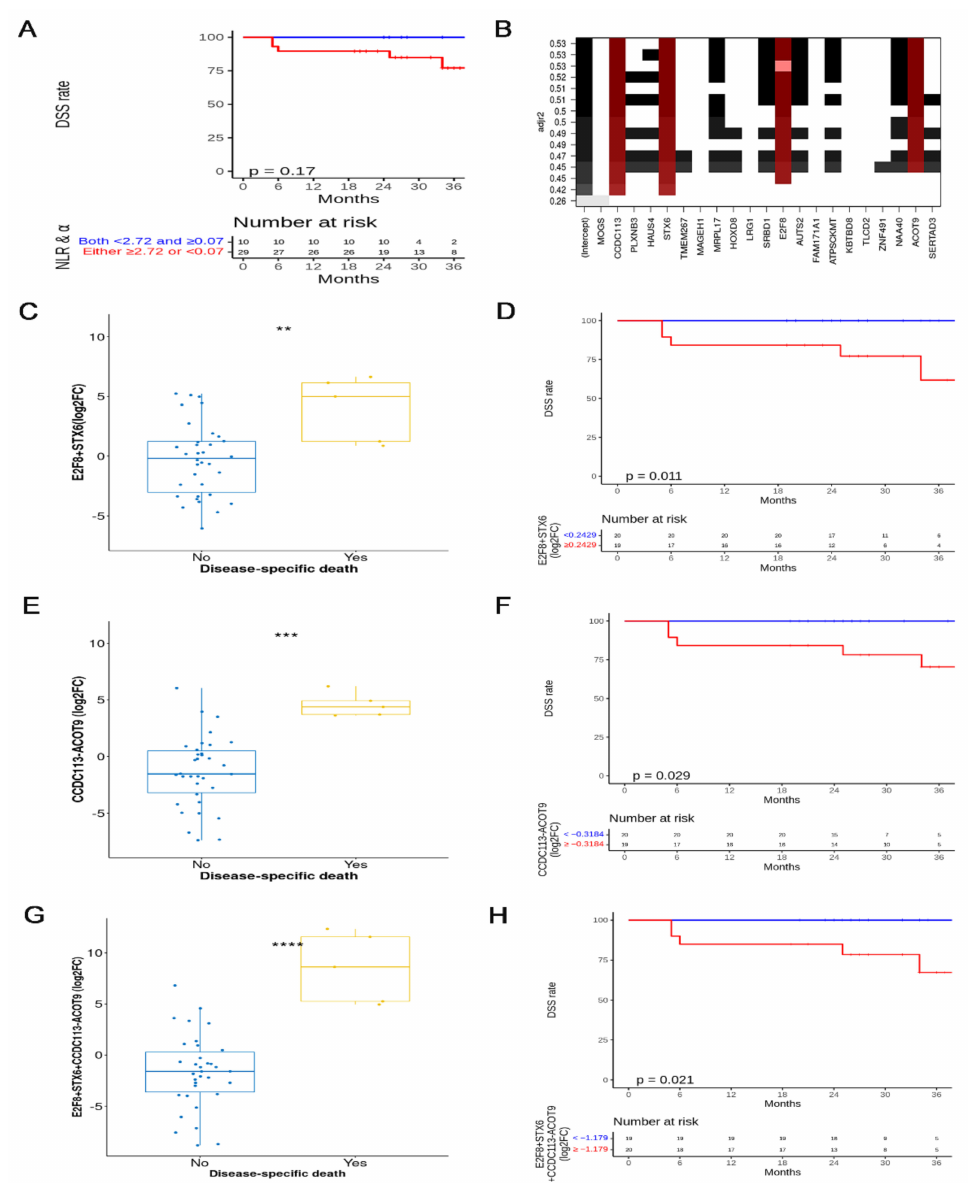
Figure 6. ( A ) Kaplan–Meier plot and log-rank test of disease-specific survival (DSS) according to the median value of both α and NLR in cohort 2. ( B ) CCDC113, STX6, E2F8, and ACOT9 were included in most of the cases to predict DSS with the subsets of 21 mRNAs from plasma exosomes, relevant to both survival and either α or NLR (red rectangles). ( C ) The sum of E2F8 and STX6 relevant to both survival and α ; ( E ) CCDC113-ACOT9 relevant to both survival and NLR; and ( G ) E2F8 + STX6 + CCDC113-ACOT9 relevant to survival, α , and NLR showed a significant difference between the two groups according to whether the patients died of cervical cancer or not, respectively. Kaplan–Meier plots and log-rank tests of DSS ( D ) according to the median value of E2F8 + STX6 ( F ) according to the median value of CCDC113-ACOT9 and ( H ) according to the median value of E2F8 + STX6 + CCDC113-ACOT9. NLR—neutrophil-to-lymphocyte ratio; ** p < 0.01, *** p < 0.001, **** p < 0.0001. The ratio of adjusted R 2 to the number of selected mRNAs was the highest when 4 of the 21 mRNAs, correlated with α or NLR to predict DSS, were selected (Figure